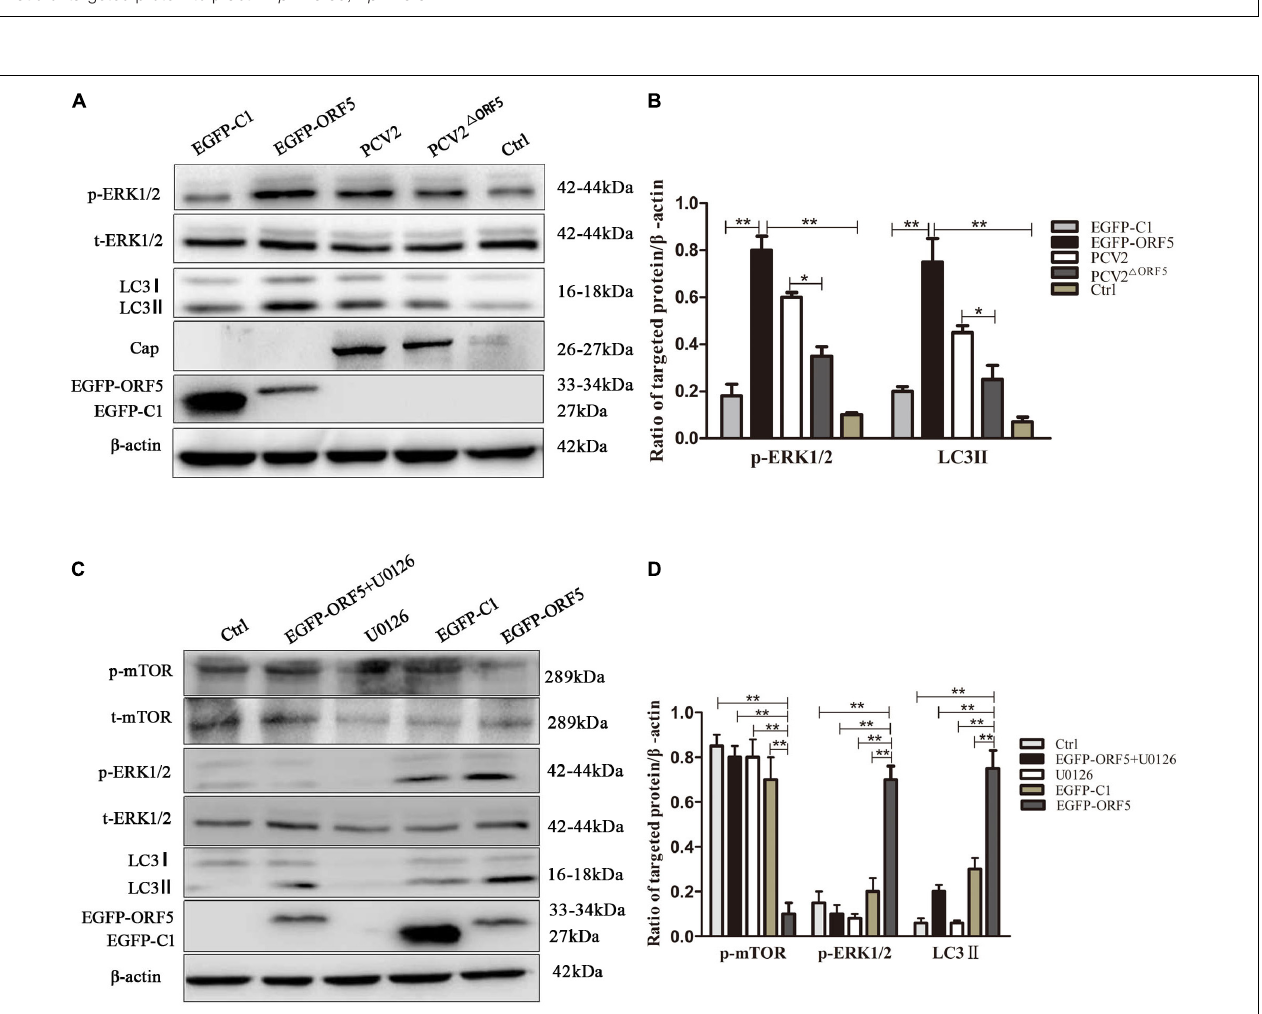
FIGURE 4 | ORF5 protein upregulates phosphorylation of ERK1/2. (A) EGFP-ORF5 was transfected for 48 h, PCV2 or PCV2 (cid:49) ORF5 was infected for 36 h, p-ERK1/2, t-ERK1/2, LC3II were detected by immunoblotting. (B) Perform a T -test on the grayscale analysis of the A picture, the ratio of targeted protein to β -actin. (C) PK-15 cells were pretreated with U0126 for 2 h and then transfected with EGFP-ORF5 or EGFP-C1 for 48 h, p-mTOR, t-mTOR, p-ERK1/2, t-ERK1/2, LC3II were detected by immunoblotting. (D) Perform a T -test on the grayscale analysis of the (C) , the ratio of targeted protein to β -actin. * p < 0.05, ** p < 0.01.